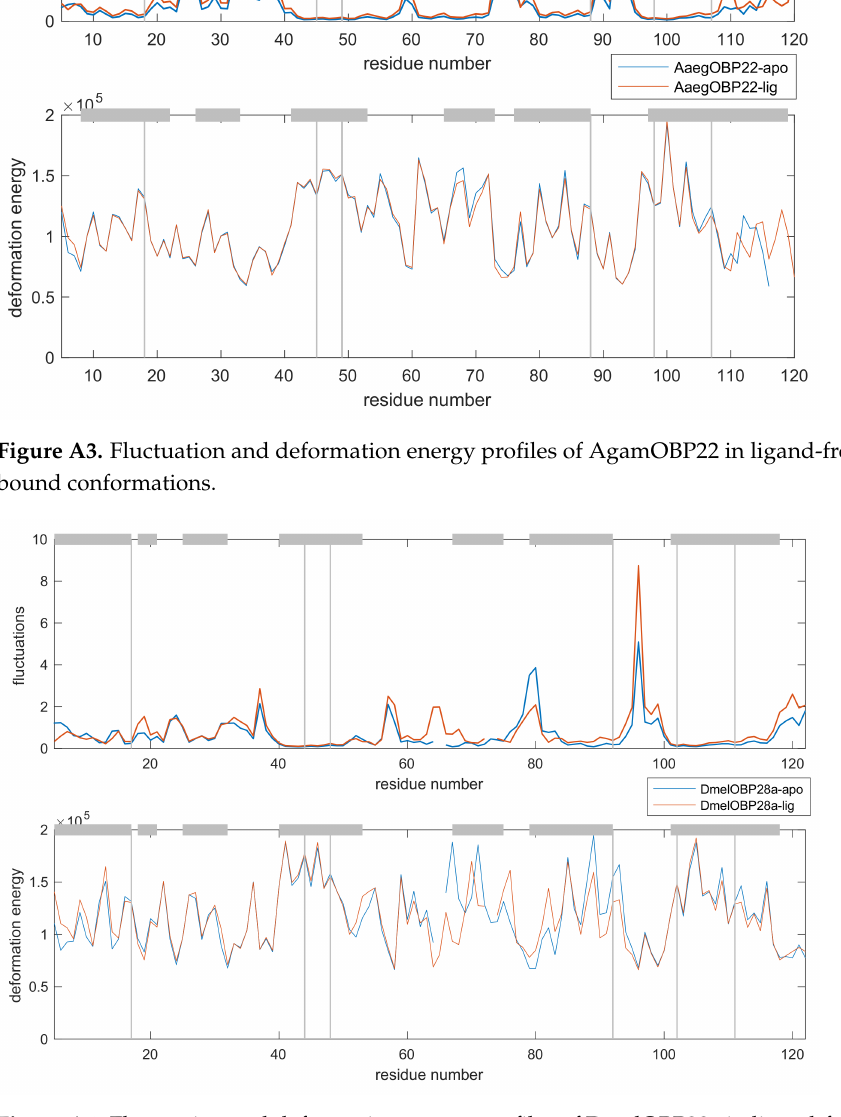
Figure A4. Fluctuation and deformation energy profiles of DmelOBP28a in ligand-free and ligand- bound